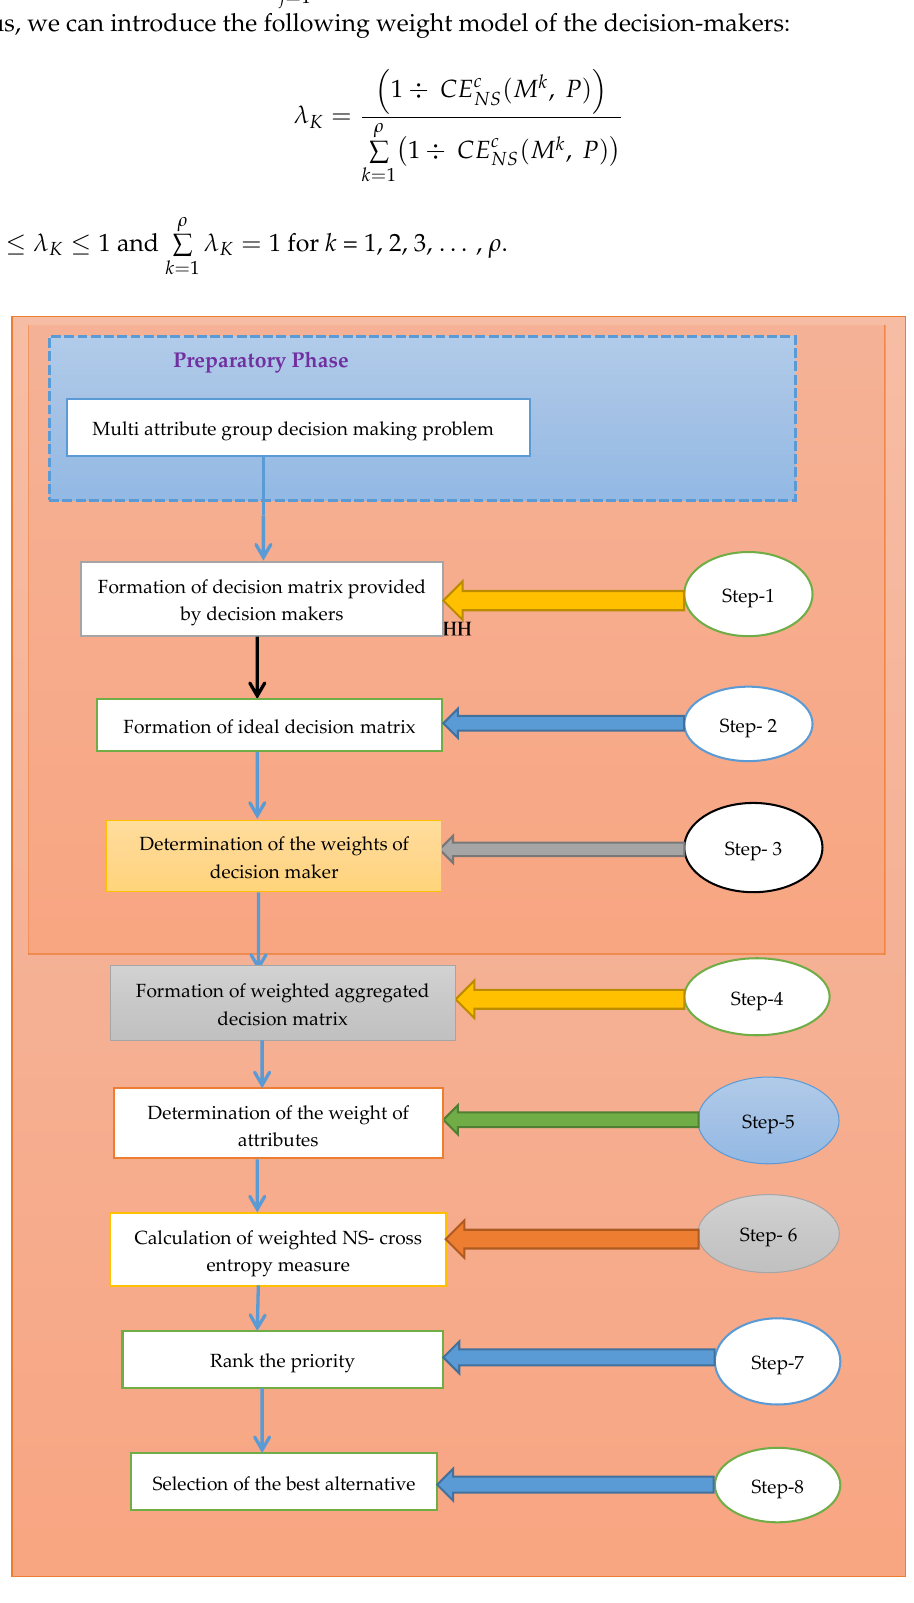
Figure.1 Decision making procedure of the proposed MAGDM strategy Figure 1. Decision-making procedure of the proposed MAGDM